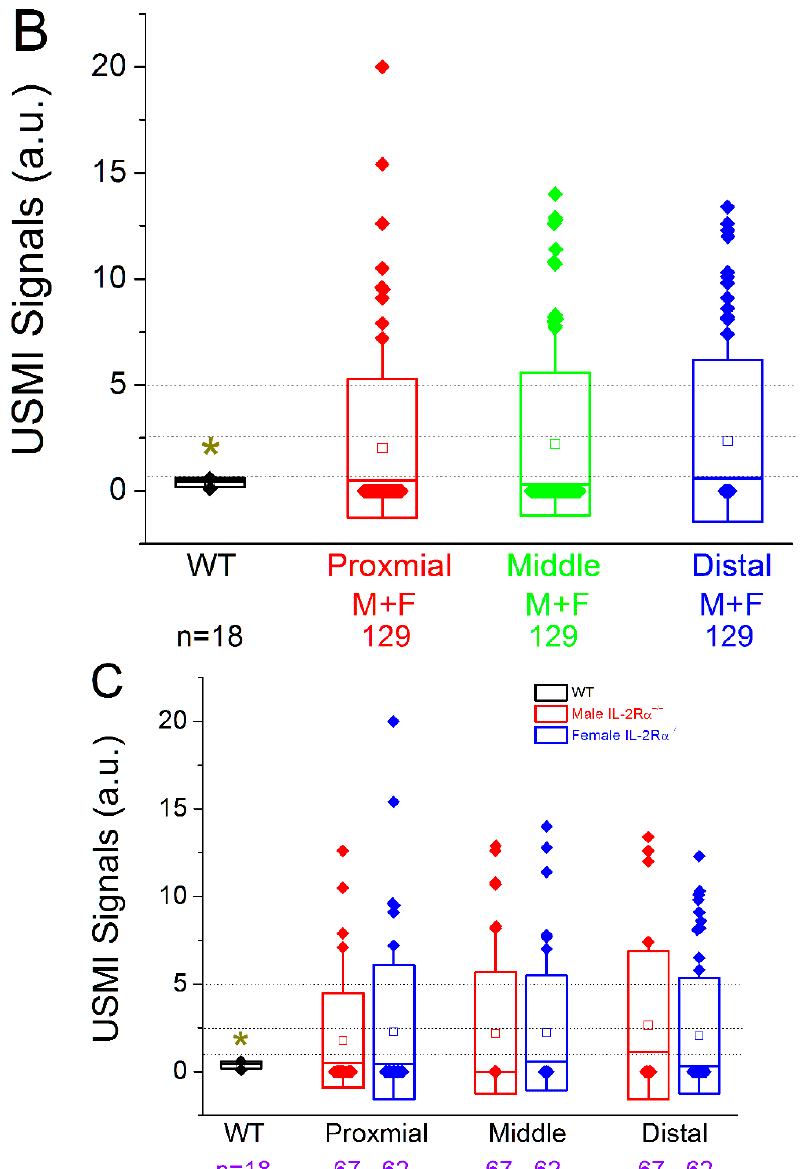
Figure 3. IL-2R α -/- mice showed spontaneous colitis without sex or locational difference between 6–30 weeks of age. ( A ) The mean USMI signals of all the imaging acquisitions from proximal, middle and distal colon in both male and female IL-2R α -/- mice were significantly higher than wild-type mice, and there was no significant difference in USMI signals between male and female IL-2R α -/- mice. ( B ) When the imaging acquisitions were pooled according to proximal, middle and distal colon in both male and female IL-2R α -/- mice, the mean USMI signals of proximal, middle, and distal colon were significantly higher than wild-type mice, and there was no significant difference in USMI signals observed between proximal, middle and distal colon in both male and female IL-2R α -/- mice. ( C ) When USMI signals of proximal, middle, and distal colon were further divided according to male and female IL-2R α -/- mice, mean USMI signals of proximal, middle, or distal co- lon in either male or female IL-2R α -/- mice were significantly higher than wild-type mice, and did not show a significant difference in USMI signals between the 3 locations or between the sexes. Each box in the plot represents the 25th and 75th quartiles while the line inside the box identifies the median. The small square within the box indicates the mean. ♦ represents outliers; * indicates p -value < 0.05 between the two boxes under the bar ( A ) or between the box of wild-type mice and any box in IL-2R α -/- mice ( B,C ).